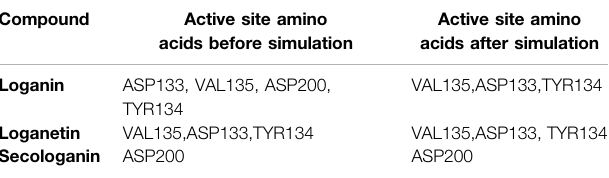
Frontiers in Chemistry |